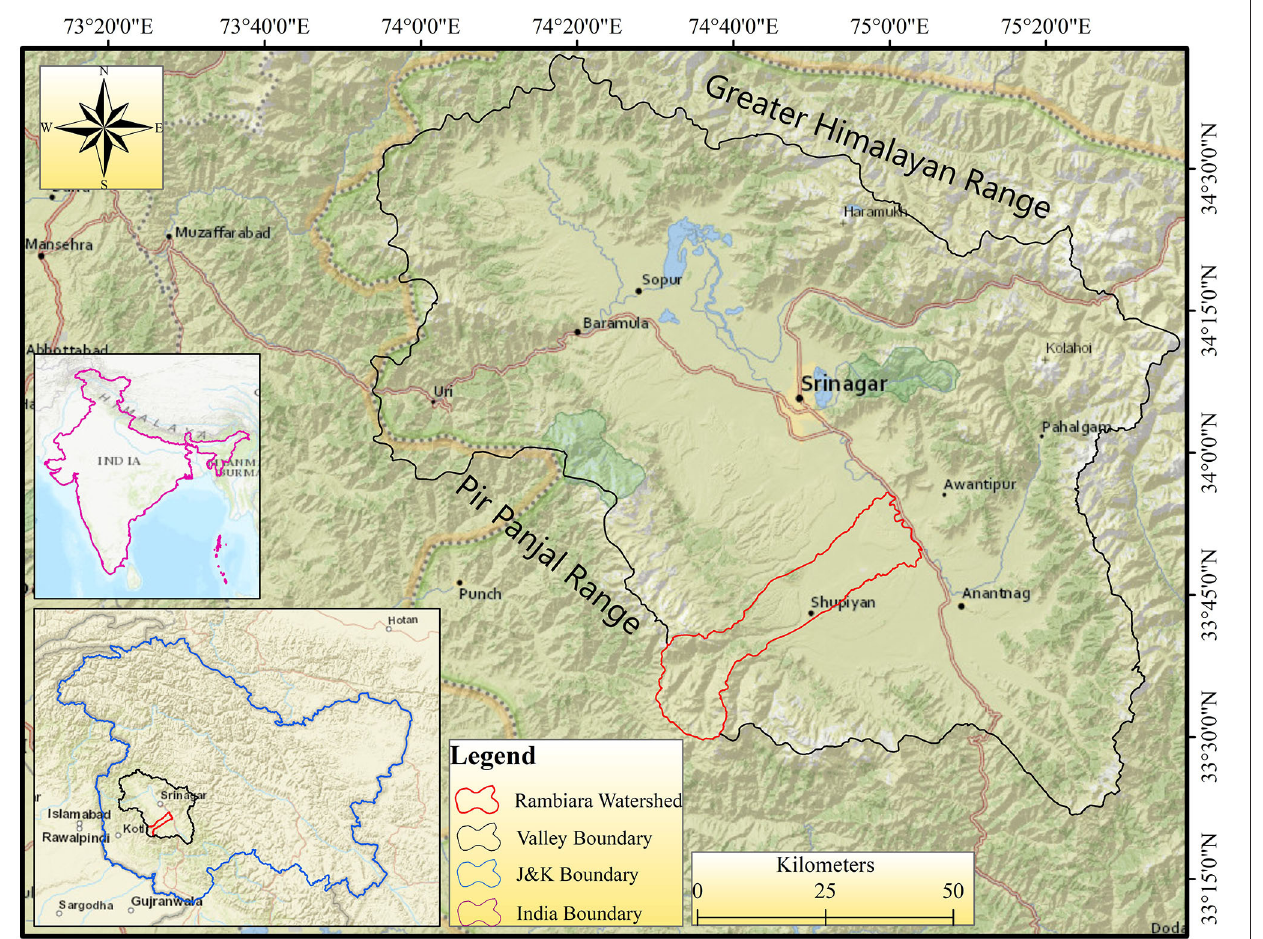
FIGURE 1 | Relief map of the Kashmir valley and the adjoining areas showing the location of the study area (Rambiara